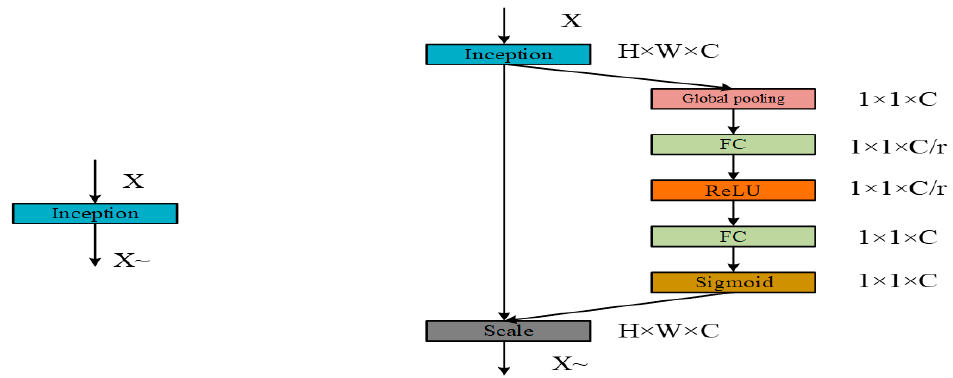
Figure 2. Original Inception module ( left ) and SE–Inception module ( right ).